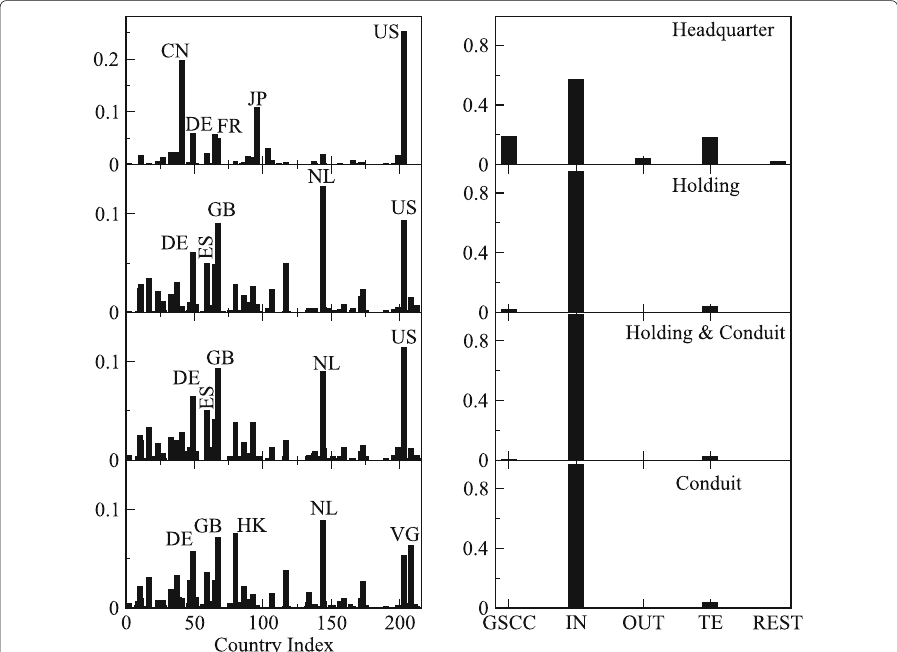
Fig. 10 Distribution of the headquarters and the key companies of the MNCs subject to this analysis. The left bar plots show the geographical distributions, while the right bar plots show the distributions in the bow-tie structure of the GWCC of the GON. The bar plots of both sides show regarding the headquarters, the “holding” companies, the “holding and conduit” companies, and conduit” companies from top to bottom. REST stands for the component except the